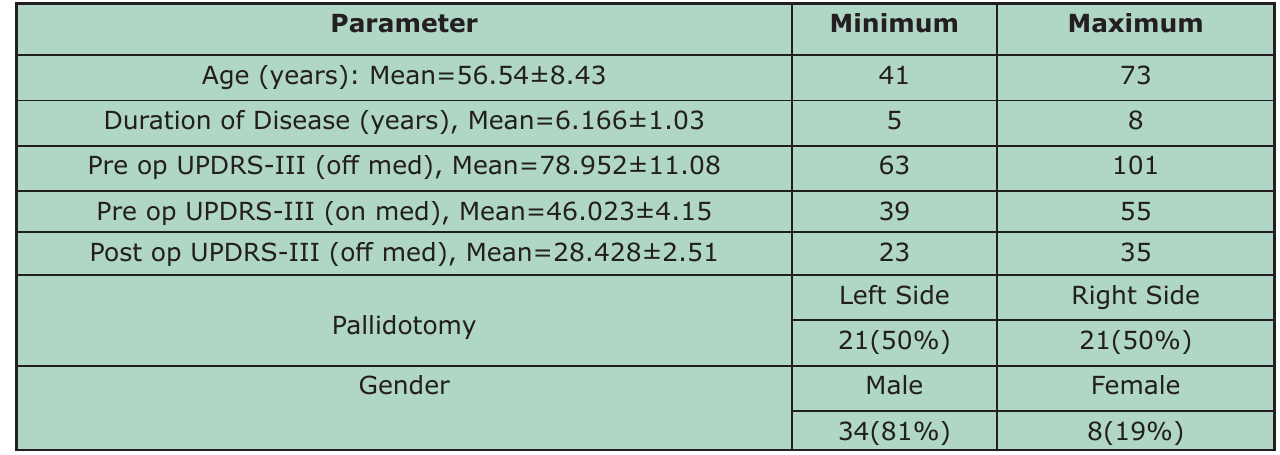
Gender.Stratification of Left/Right Side Proportions in Age Groups and